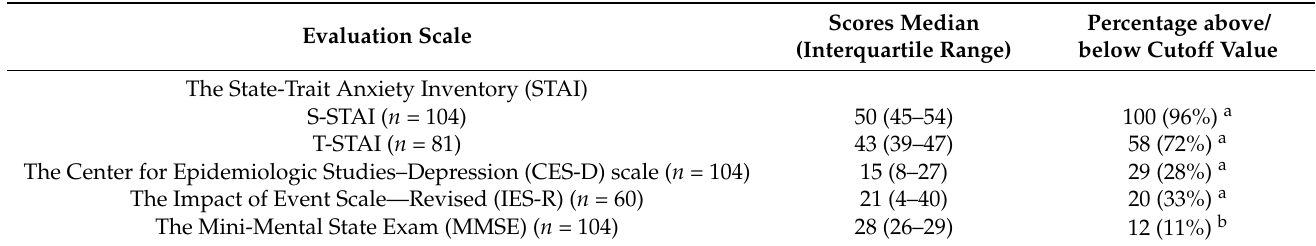
Table 2. The follow-up assessment results for anxiety, depression, post-traumatic stress disorder, and cognitive function. Evaluation